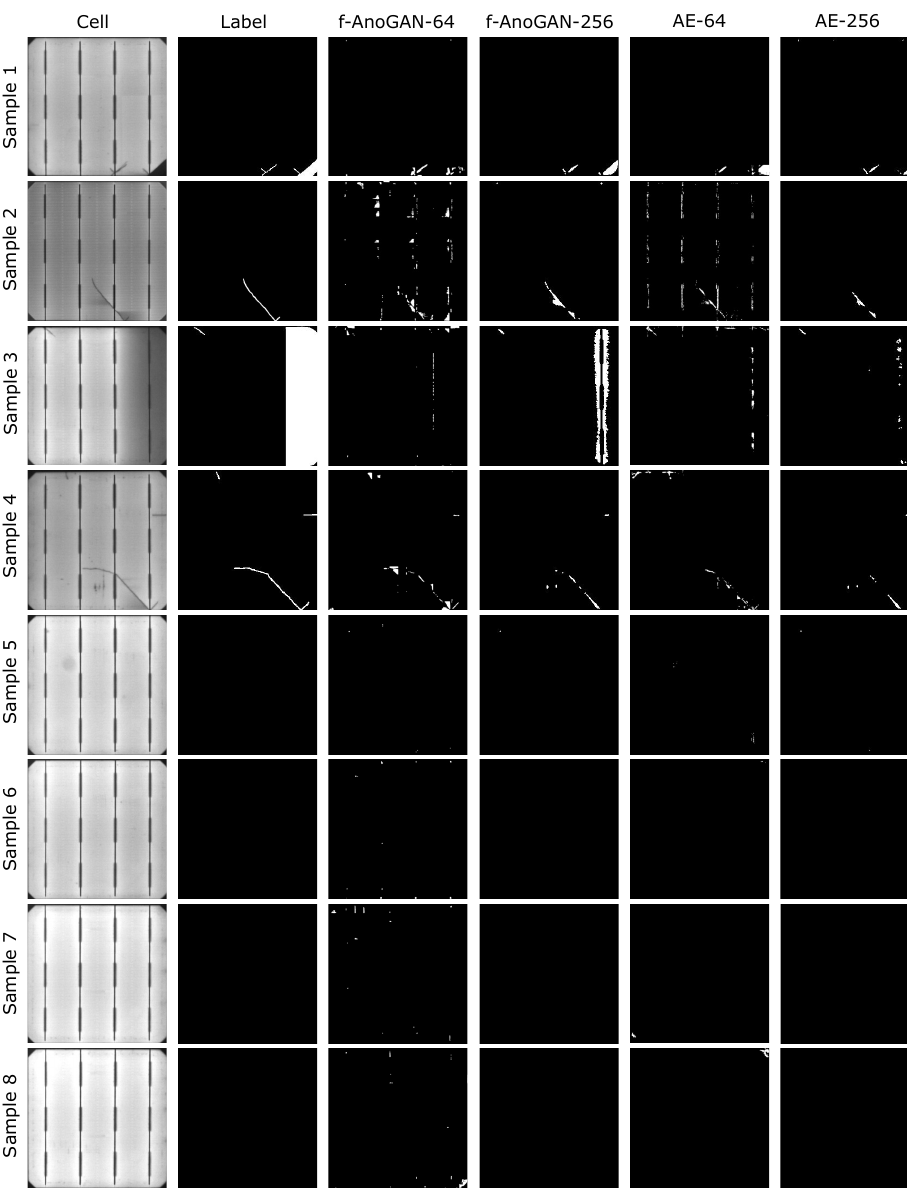
Figure 8. Defect localization results from each